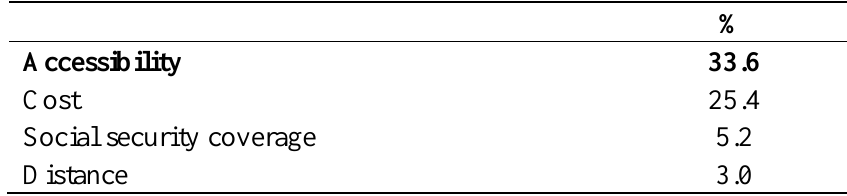
Table 2. Distribution of reasons for unmet health